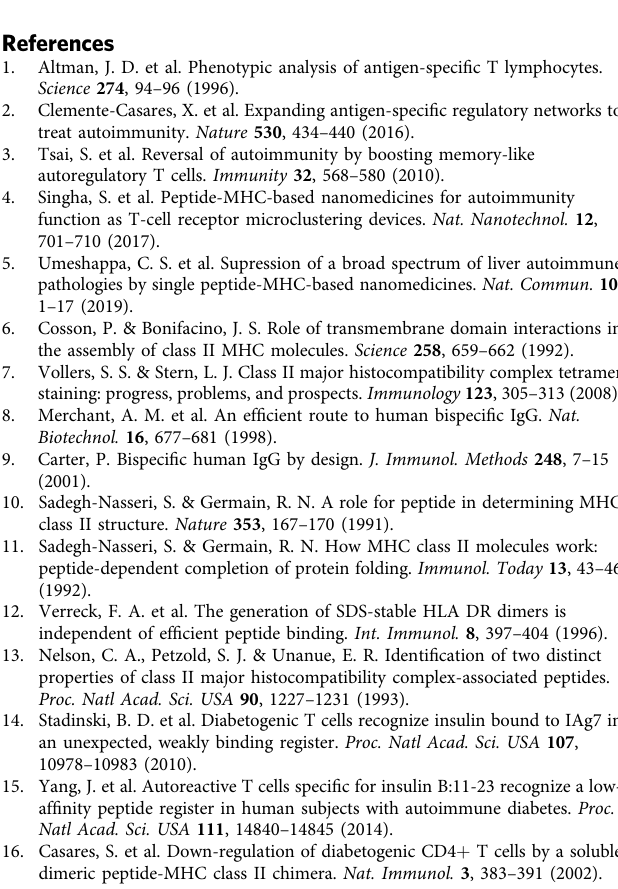
Reporting summary . Further information on research design is available in the Nature Research Reporting Summary linked to this article.